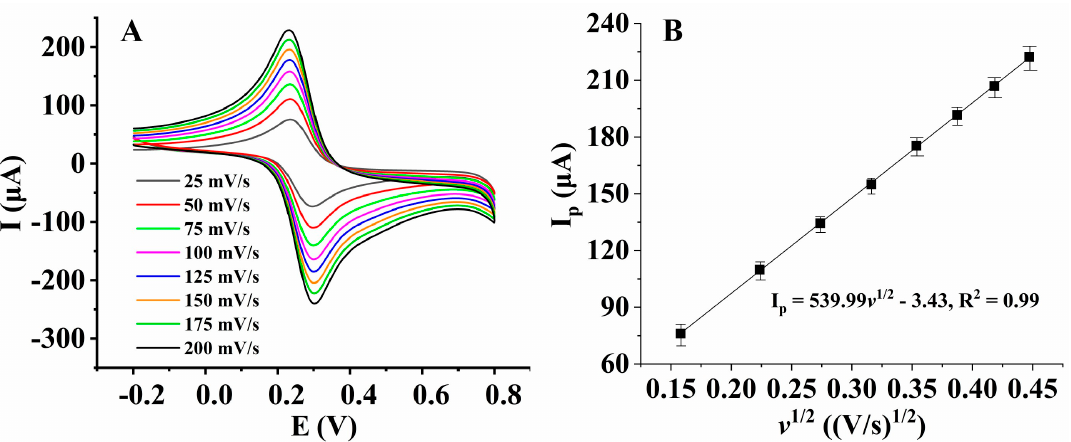
Figure 8. ( A ) Cyclic voltammograms of AuNPs/AB–DHP/GCE in 5 mM Fe(CN) 63 − /4 − + 1 M KCl solution at different scan rates. ( B ) The linear relationship between the reduction peak current of Fe(CN) 63 − /4 − and the square root of the scan rate.